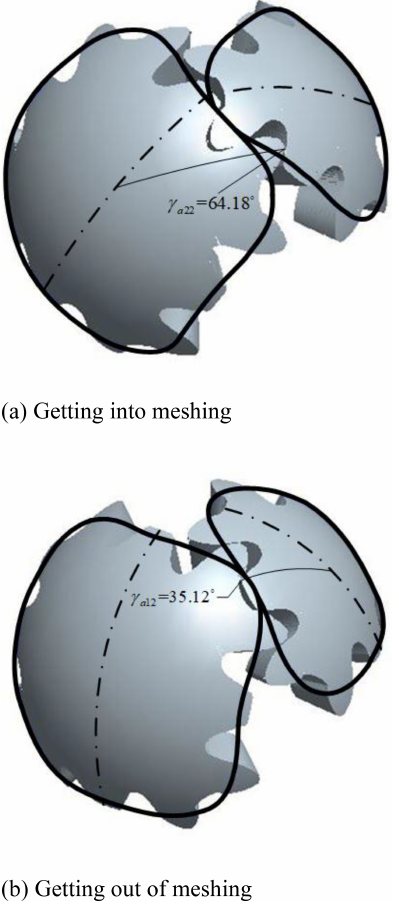
Figure 11. Meshing process (Case 2).